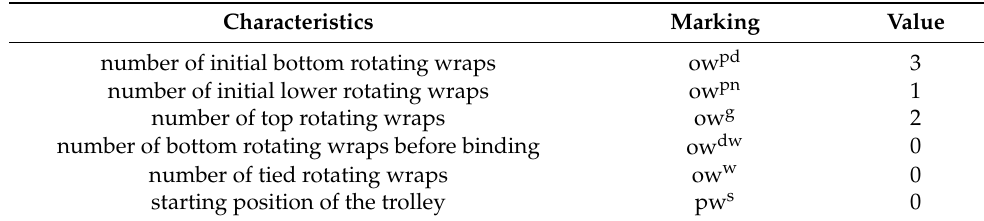
Table 4. Characteristics of cargo application with standard film.